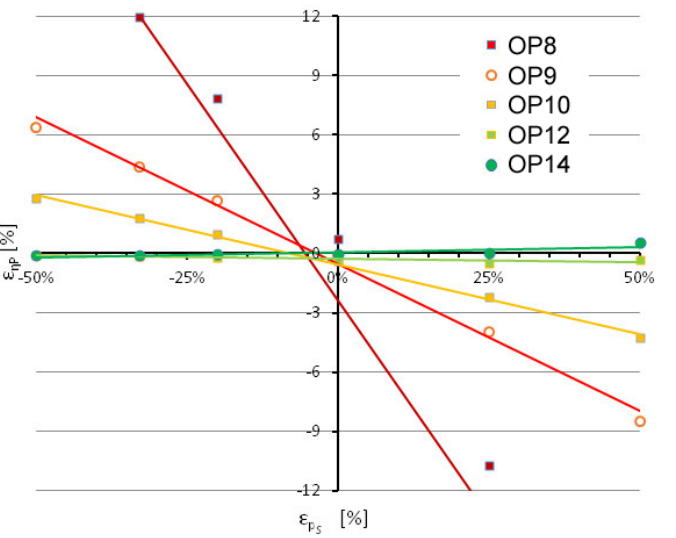
Figure 9. The algorithm sensitivity analysis regarding the determination of the pump efficiency (cid:101) η for deviations in the reading of the suction pressure (cid:101) p OP12 and OP14.